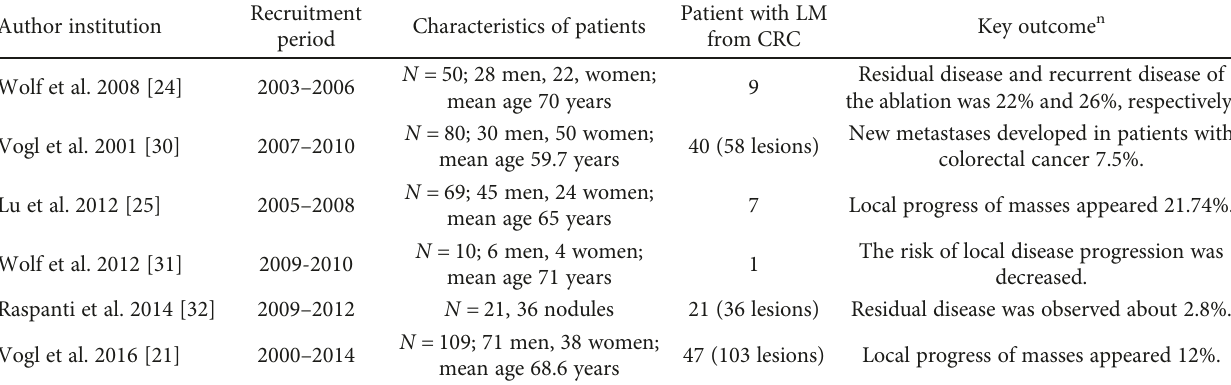
Patient with LM